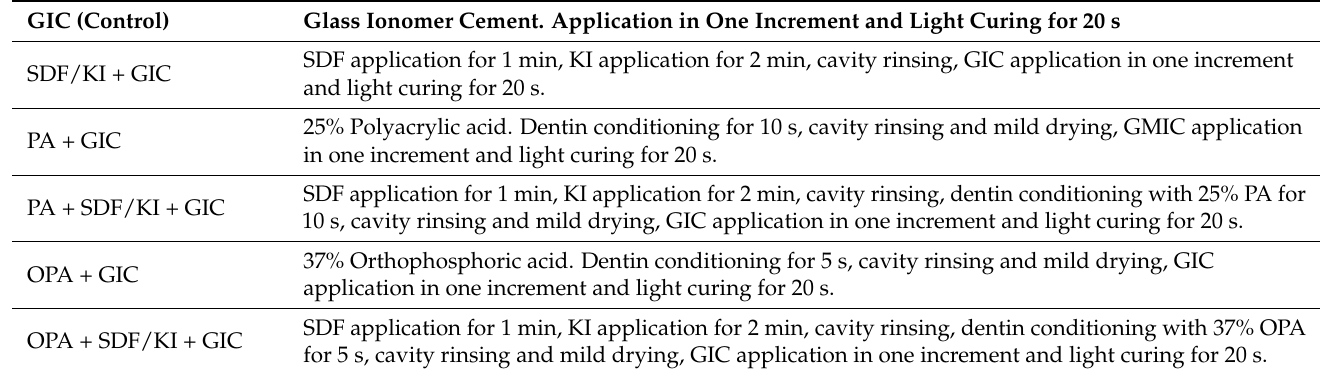
Table 2. Study subgroups accordingly dentin conditioning procedures and SDF/KI application ( n = 10 cavities) in each subgroup.